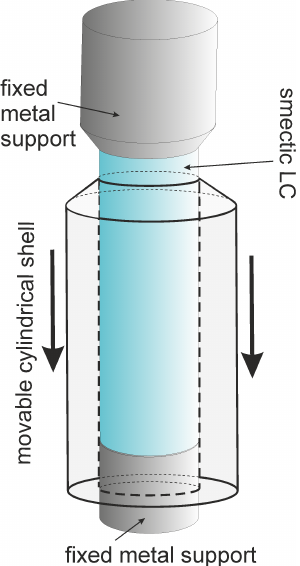
Figure 2. Sketch of the TEXUS 52/TEXUS 55 liquid-crystal bridge experiment. The liquid or liquid- crystal (the bright bluish column) is initially encapsulated by a cylindrical metal hull with an inner diameter of 3 mm. This shell is pulled away from the opposing support of the bridge and a fast camera captures images of the free column at rates of 50 or 100 frames per